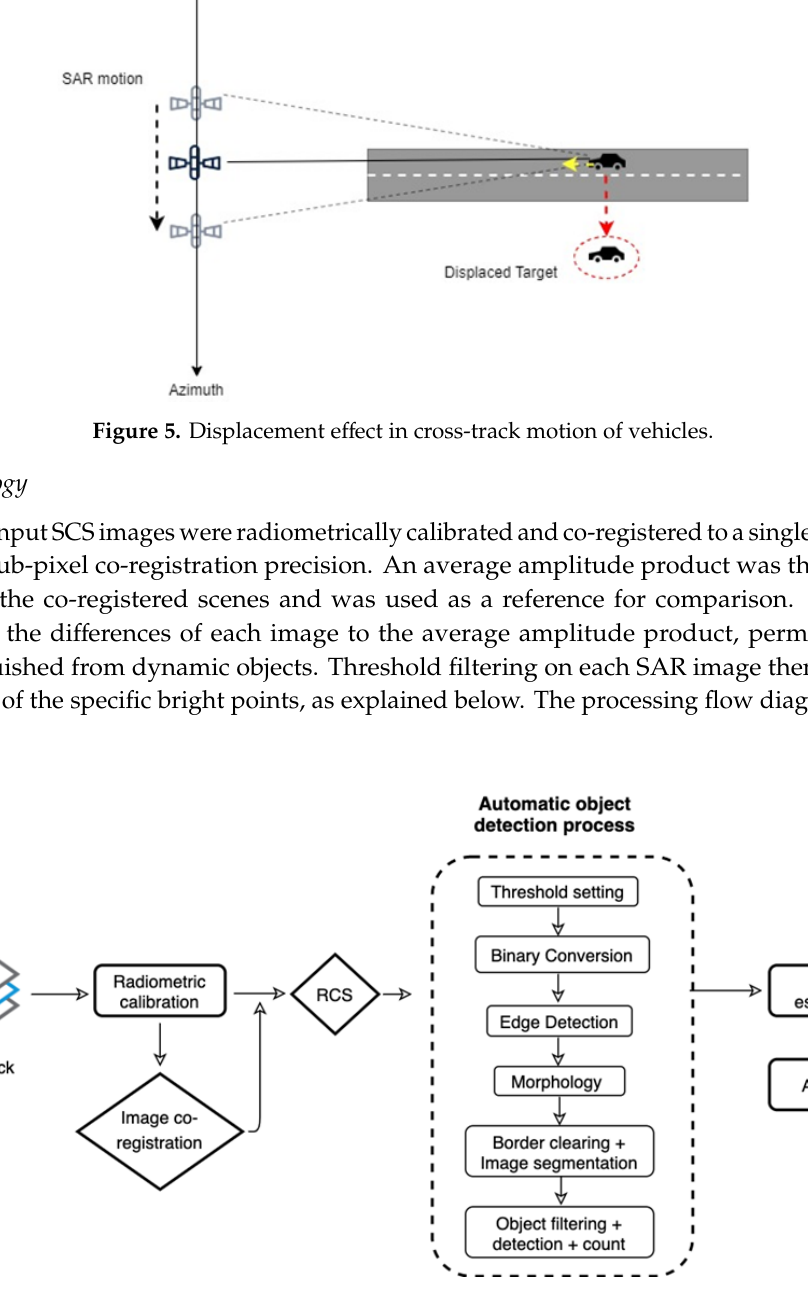
Figure 6. Workflow of the proposed method for the detection of moving vehicles based on SAR amplitude imagery.